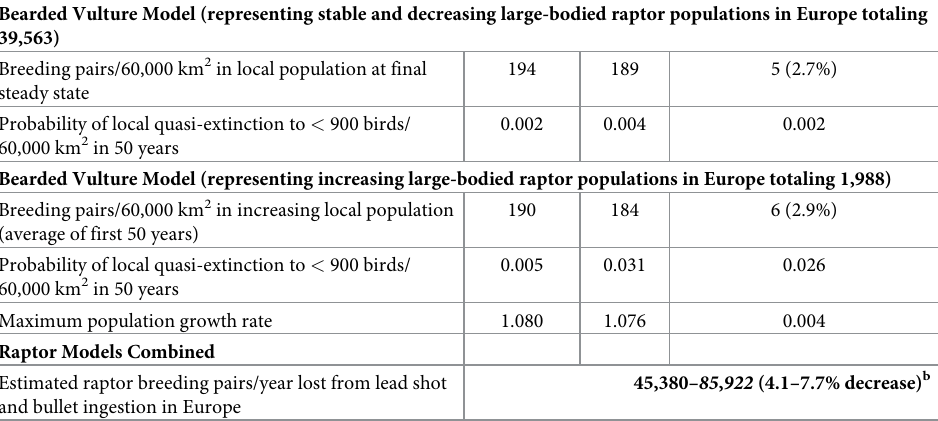
reproduction comprised 28 to 42% of the loss (Tables 3 and 4). The population size reduction, whether with or without reproductive effects, was smaller than or similar to the natural vari- ability in the population size of these small-bodied raptors (Figs 4 and 5) and may be difficult